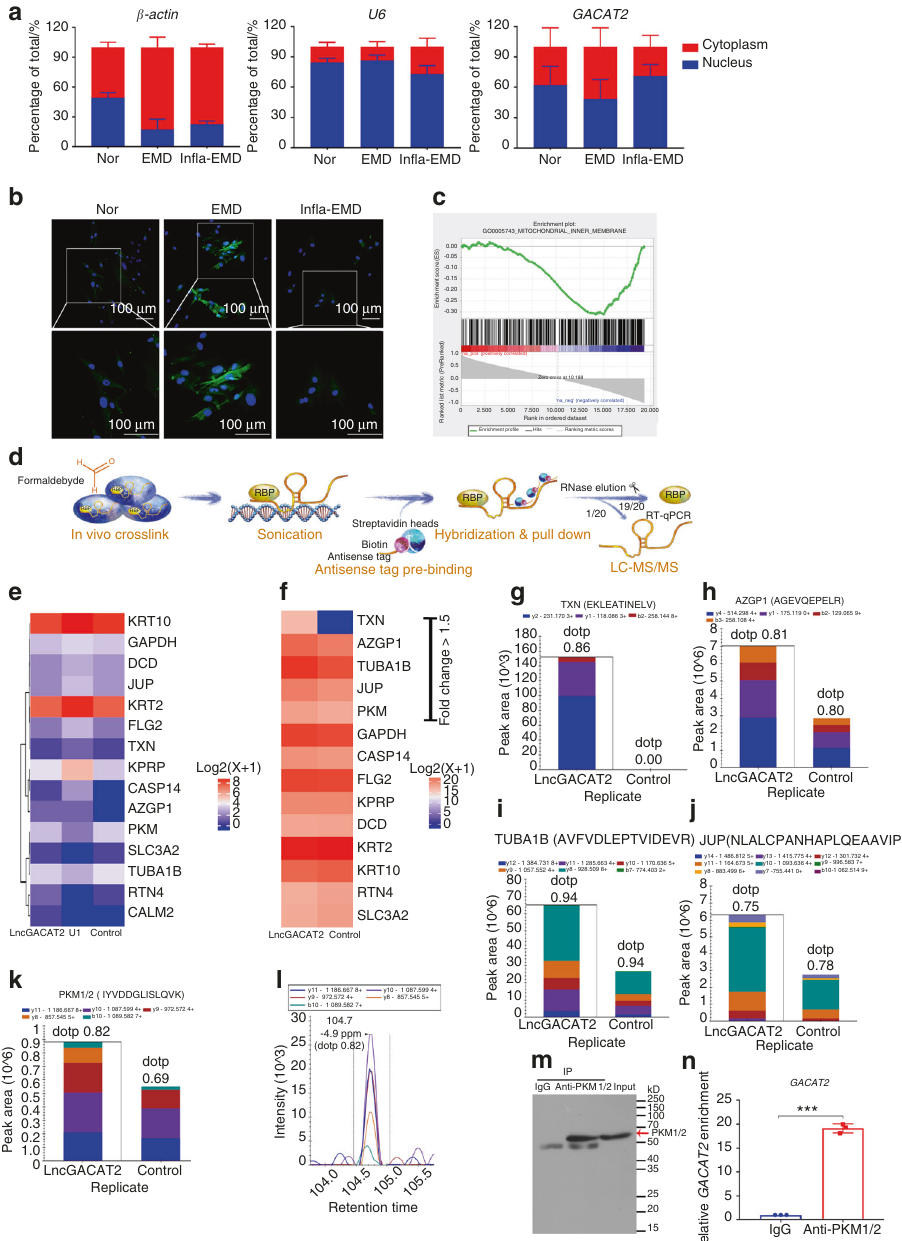
Fig. 6 Identi fi cation and validation of PKM1/2 as a direct binding protein of GACAT2 that in fl uences mitochondrial function. a and b Determination of GACAT2 localization in both the cytoplasm and nucleus of PDLSCs. The cells were incubated in normal α -MEM (Nor), medium with the cementoblastic inducer EMD (EMD), or medium with both in fl ammatory cytokines and EMD (In fl a-EMD). a Percentages of nuclear and cytoplasmic GACAT2 determined by qRT-PCR ( U6 and β -actin served as the nuclear and cytoplasmic controls, respectively). b Subcellular localization of GACAT2 determined by the RNA SCOPE assay (scale bar: 100 μ m). c GACAT2 expression was negatively correlated with mitochondrial inner membrane-associated gene signatures (GSEA). d The ChIRP method was applied to screen the potential proteins binding to GACAT2 . e Heatmap of 15 GACAT2 -binding proteins screened by ChIRP-MS assays (unique peptide ≥ 2, fold change >1.2); U1 probes were used as the positive control (U1), and nontargeting probes (control) were used as the negative control. f Quanti fi cation of labeled reference peptides for GACAT2 -binding proteins (PRM assay, nontargeting probes were used as the negative control). g – k Product ion pattern of the selected proteins (fold change >1.5), i.e., TXN ( g ), AZGP1 ( h ), TUBA1B ( i ), JUP ( j ) and PKM1/2 ( k ) (PRM assay; EKLEATINELV for the TXN protein, AGEVQEPELR for the AZGP1 protein, AVFVDLEPTVIDEVR for the TUBA1B protein, NLALCPANHAPLQEAAVIPR for the JUP protein, and IYVDDGLISLQVK for the PKM1/2 protein); nontargeting probes were used as controls; different colors indicate different fragment ions from the same polypeptide, and each peptide was quanti fi ed using fragment ions. l Chromatograph of a labeled peptide (IYVDDGLISLQVK) for the PKM1/2 protein; PKM1/2 was selected for further veri fi cation because it is more closely related to mitochondrial function than AZGP1, TUBA1B and JUP (based on information arising from the UniProt Database), and TXN was excluded from further investigation due to its inappropriate chromatography (Fig. S15). m and n Con fi rmation of the interaction between PKM1/2 and GACAT2 by RIP assays. The PKM1/2 protein immunoprecipitated by the anti-PKM1/2 antibody was veri fi ed by immunoblotting analysis ( m ), and the enrichment of GACAT2 immunoprecipitated by anti-PKM1/2 antibodies was determined by RIP assays ( n ) (IgG antibodies were used as the control). The data